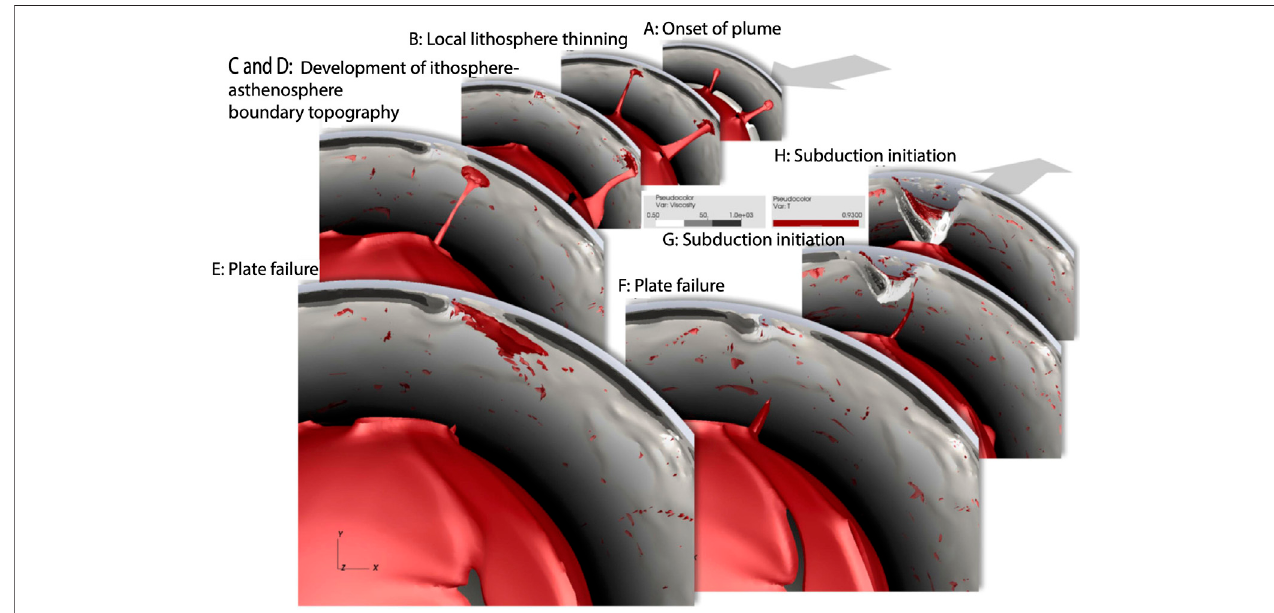
FIGURE 5 | Plume-induced subduction initiation in the global convection model of Crameri and Tackley (2016). (A) Onset of plume, (B) local lithosphere thinning, (C,D) development of strong lithosphere-asthenosphere boundary topography, (E,F) plate failure, and fi nally (G,H) self-sustaining subduction initiation. Plates and mantle plumes are shown in grey and red, respectively (from Crameri and Tackley